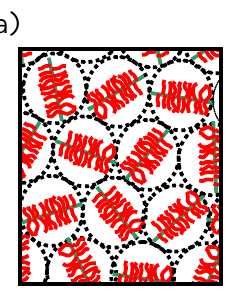
Figure 3. Two overlap concentrations are observed in comb polymer solutions